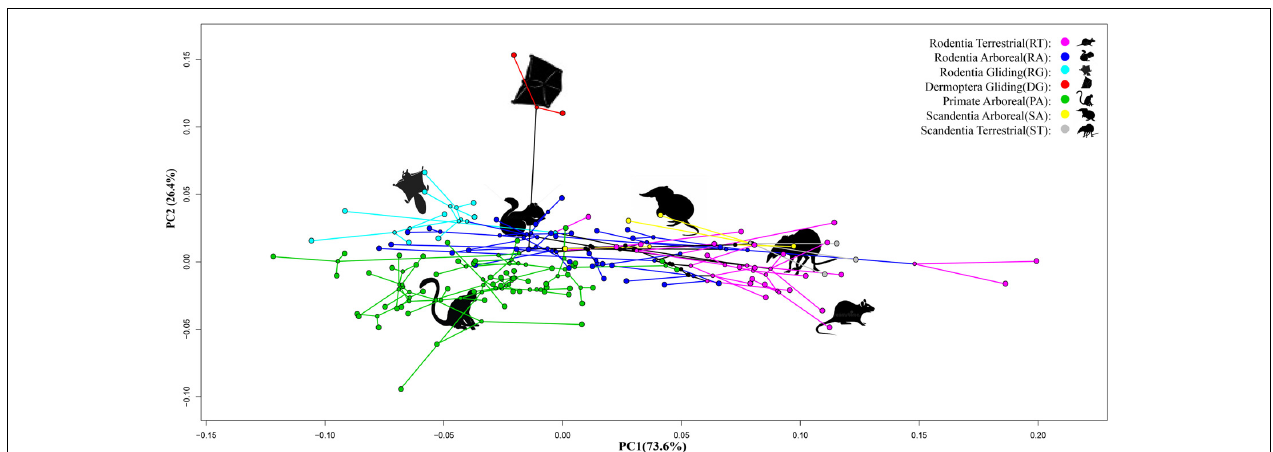
FIGURE 2 | Phylomorphospace plot of 122 Euarchontoglire species based on the scores of a principle component analysis (PCA) of three phalangeal indices of manual digit III. The yellow color represents the Scandentia Arboreal (SA) species; the gray color represents the Scandentia Terrestrial (ST) species; the red color represents the Dermoptera Gliding (DG) species; the green color represent the Primate Arboreal (PA) species; the purple color represents the Rodentia Arboreal (RT) species; the blue color represents the Rodentia Terrestrial (RT) species; the indigo color represents the Rodentia Gliding (RG) species.